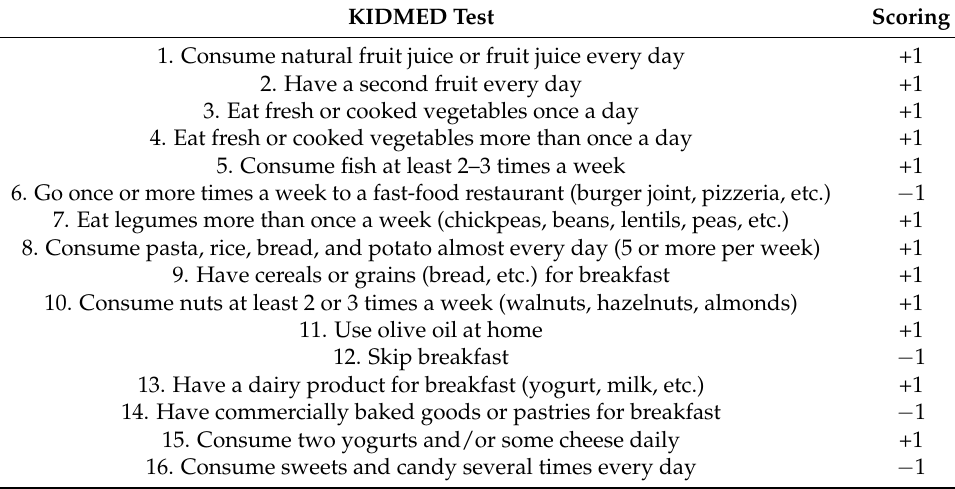
Table 1. Mediterranean Diet Quality Index